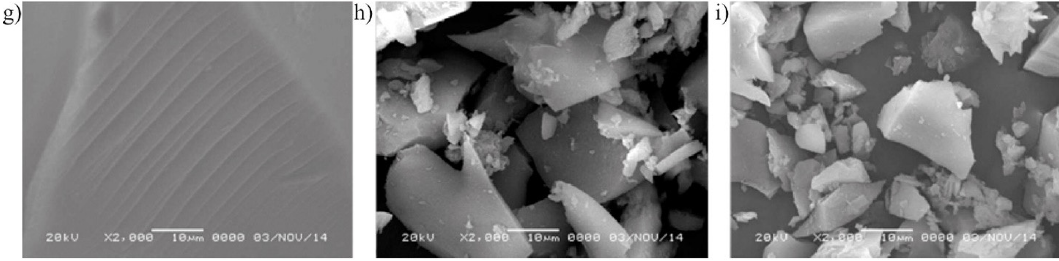
Figure 6. SEM images of SiO 2 ( a , d , g ), VTMSO-SiO 2 ( b , e , h ), and Q/VTMSO-SiO 2 ( c , f , i ) with different magnifications.